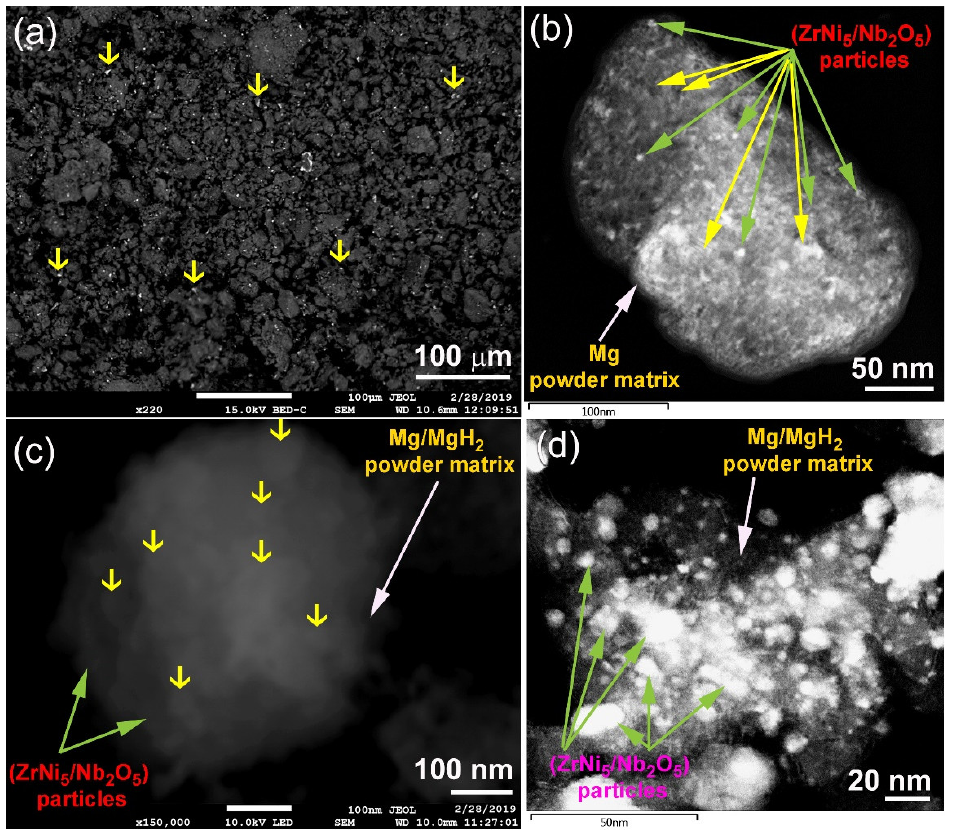
Figure 8. Kinetics of ( a , b ) hydrogenation and ( c ) dehydrogenation for nanocomposite MgH 2 doped with low, medium, and high concentrations of binary ZrNi 5 /Nb 2 O 5 catalysts after milling for 50 h.